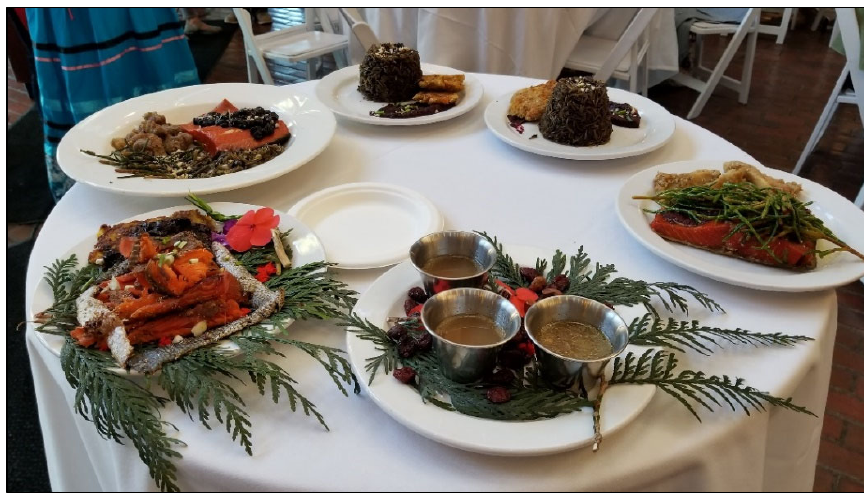
Figure 2. Plated Food from the “Native Chopped” Cooking Competition Awaiting Critique by the Elder